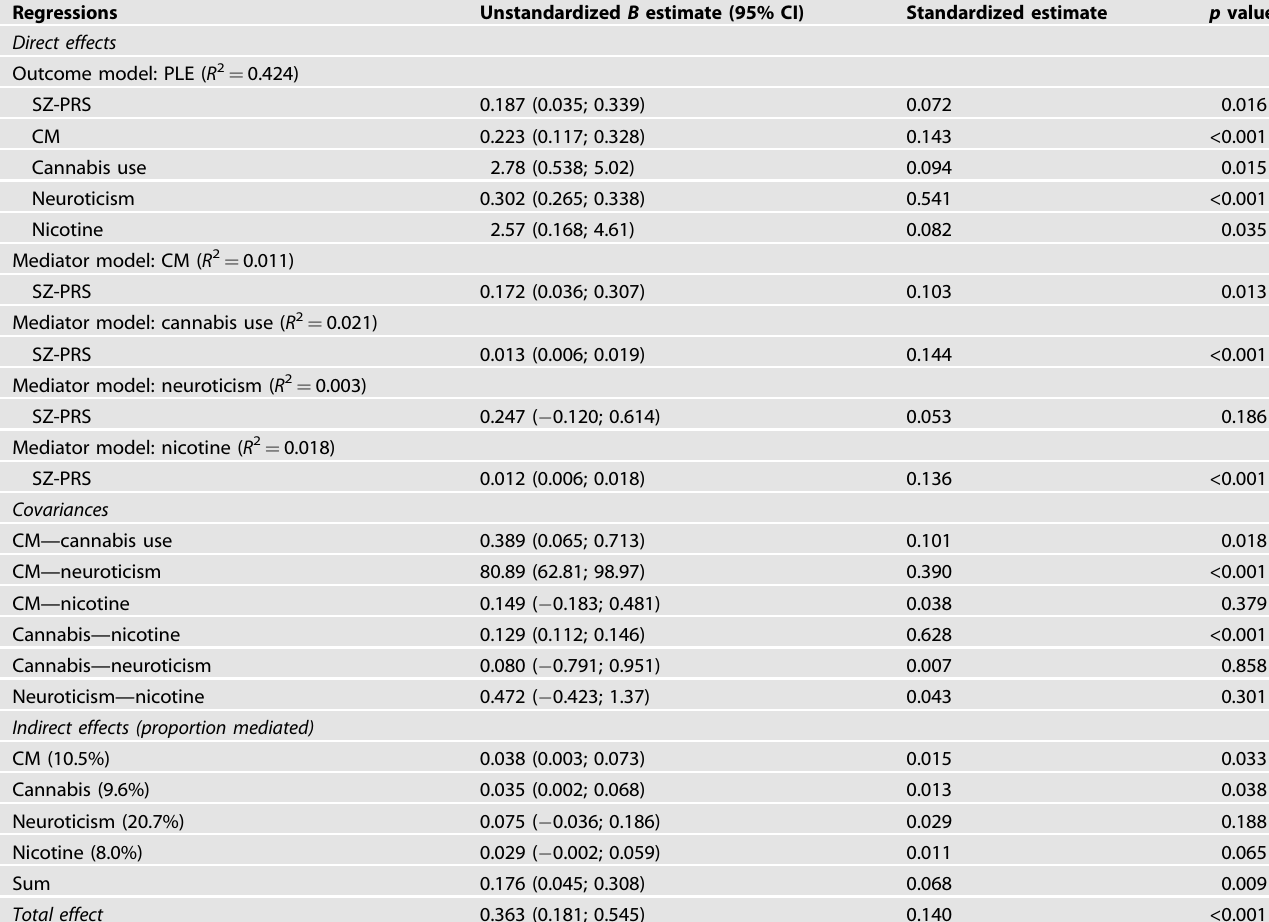
Table 3. Results of parallel four-mediator model in the discovery sample